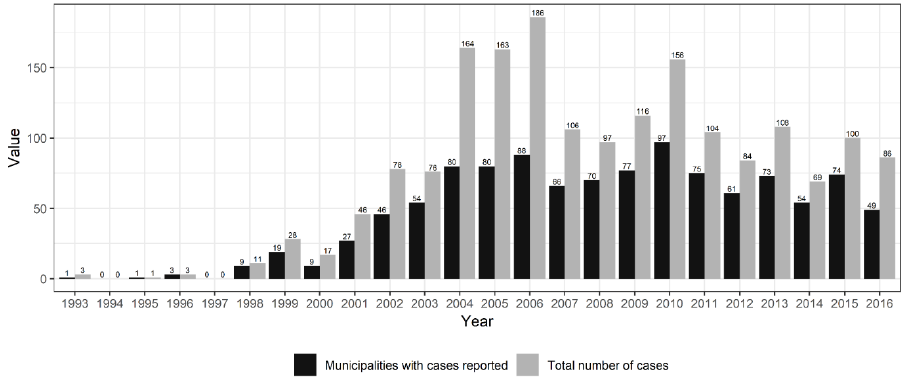
Figure 1. Hantavirus disease cases in Brazil. Data were downloaded from www.datasus.gov.br. Data from 2016 was updated in January 2019.